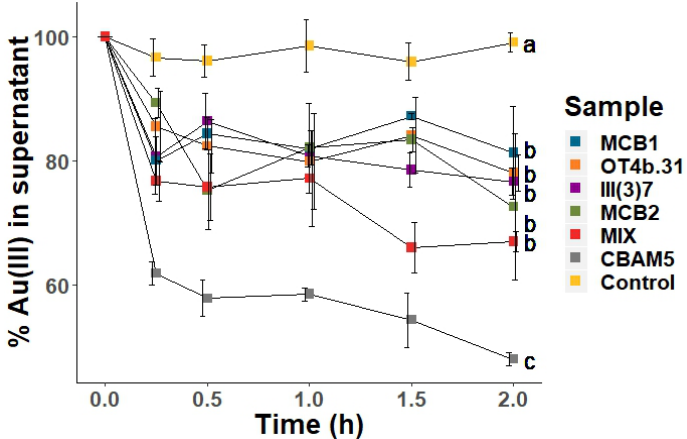
Figure 1. Gold (60 ppm) biosorption assay with free cells of L. sphaericus strains and a mixture (MIX) of some of them (CBAM5, MCB2 and III(3)7) with an OD 605 = 0.9–1.2, pH = 5–6, for 2 h. Points at 2 h denoted by a different letter differ significantly at P < 0.05 according to a one-way ANOVA and a Tukey analysis.